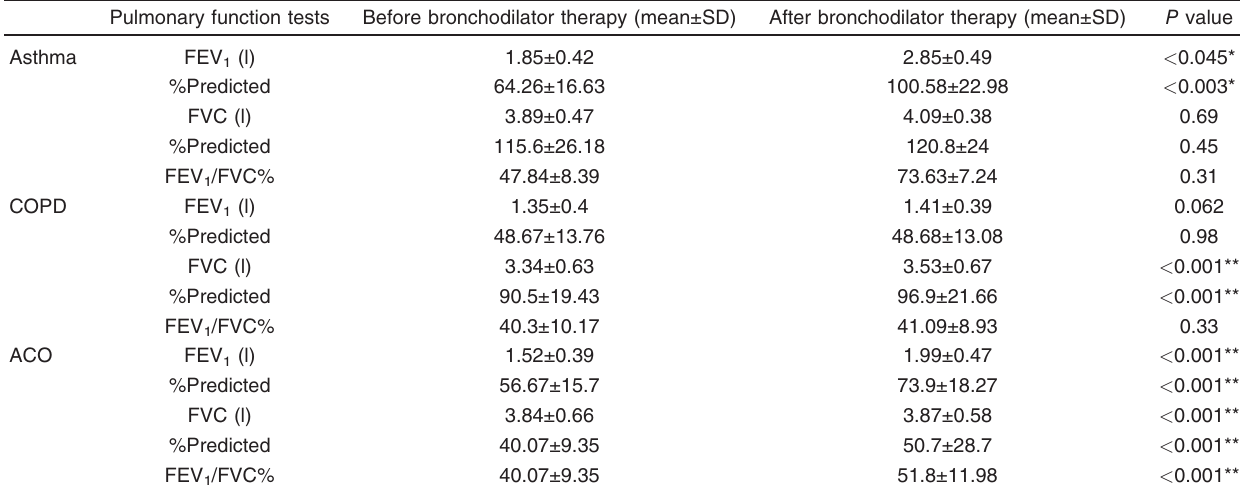
Table 2 Comparison of pulmonary function parameters (before and after bronchodilator therapy) among asthma, chronic obstructive pulmonary disease and asthma – chronic obstructive pulmonary disease overlap groups Pulmonary function tests Before bronchodilator therapy (mean±SD) After bronchodilator therapy (mean±SD)